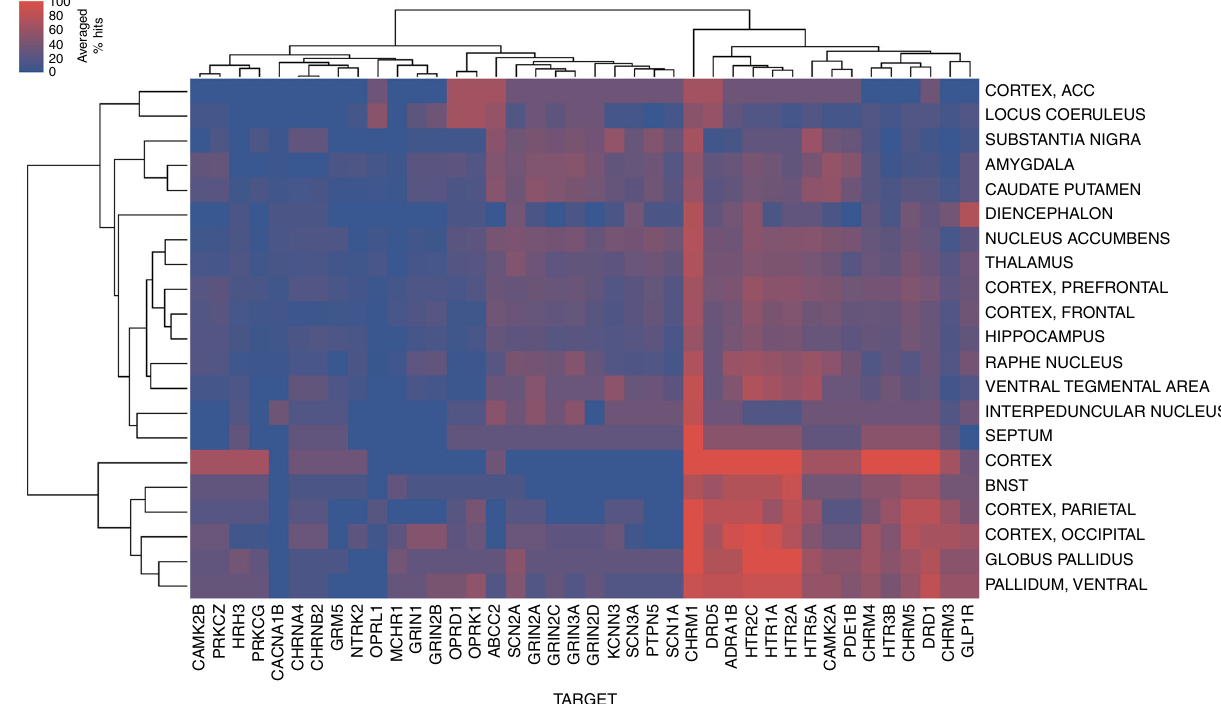
Fig. 6 Systematic analysis of bioactivities against protein targets associated with neurochemical changes across brain regions. A larger percentage (red) indicates which protein targets are more often predicted to be targeted by drugs which change a given neurotransmitter level. N.B.: Only drug targets that are clustering to at least three neurochemical components are listed here